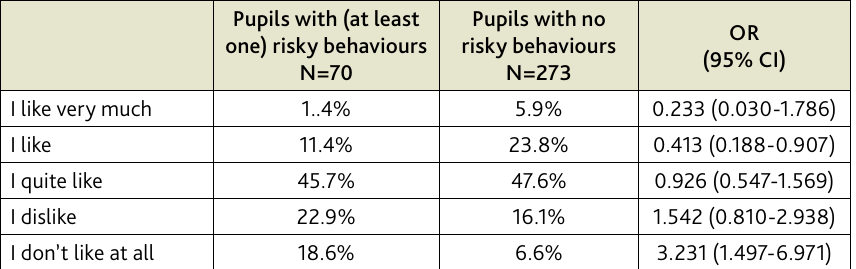
Table 3. Percentage of responses to the question “How do you like going to school?” of respondents with (at least one) and with no risky behaviours Pupils with (at